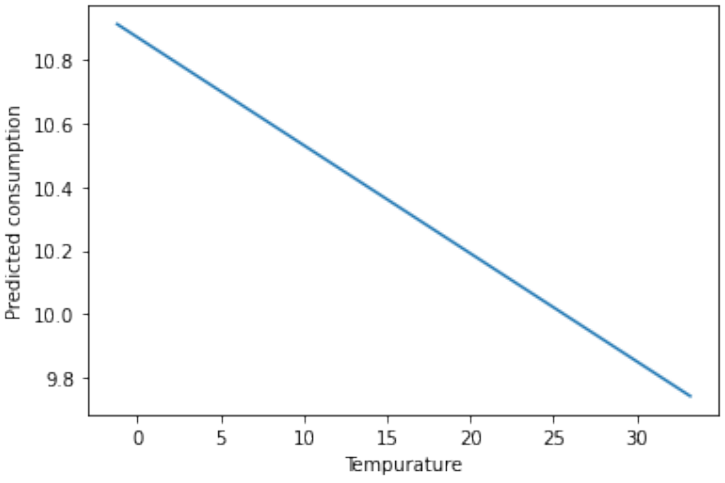
Figure 13. Impact of the temperature on the energy